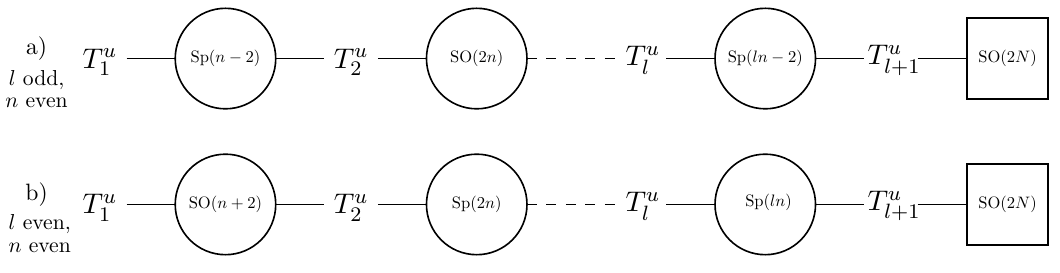
Figure 3 . Quiver for untwisted D N type theory defined using irregular singularity listed in 6.8, and a full D type regular singularity. Here we have a) l = 2 N